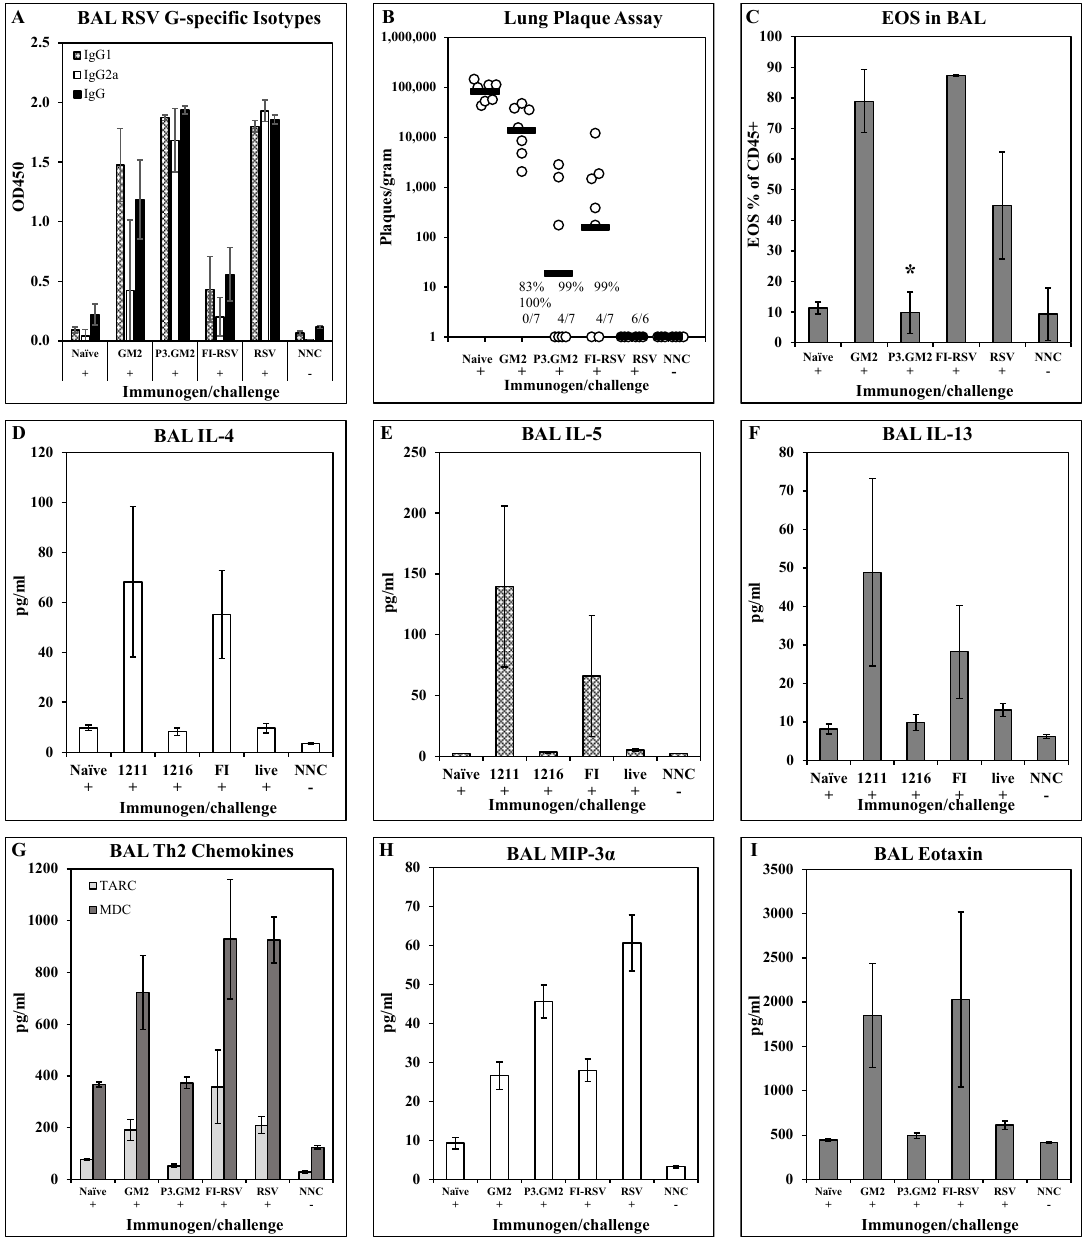
Figure 5. Impact of TLR2 engagement on post-challenge cytokine/chemokine and eosinophilia response in lungs. BALB/c mice were immunized on days 0 and 21 with GM2, Pam3.GM2, or FI-RSV, or infected on day 0 with RSV; control groups were not immunized (naïve and NNC). Mice were challenged with live RSV on day 35 (+) or not challenged ( − ). NNC = naïve, not challenged. Mice were sacrificed 5 days post-challenge and BAL were harvested for analysis. ( A ) G-specific antibody isotype levels measured by ELISA. Mean ± SEM of 3 mice per group at 1:5 BAL dilution. ( B ) Lung viral burdens. Plaques/gram of lung tissue for individual mice (open circles) and group means (red bars). Insets show number of mice with no detectable plaques ( n = 6–7 mice per group), average % reduction in plaques per group, and * p < 0.05 compared to the naïve group. ( C ) Eosinophil counts in BAL collected on day 8 post-challenge. Mean ± SEM of 6 mice per group. * p < 0.05 compared to GM2 and FI-RSV groups. ( D – I ) Cytokine and chemokine content of BAL fluids. Mean ± SEM of 6 mice per group.